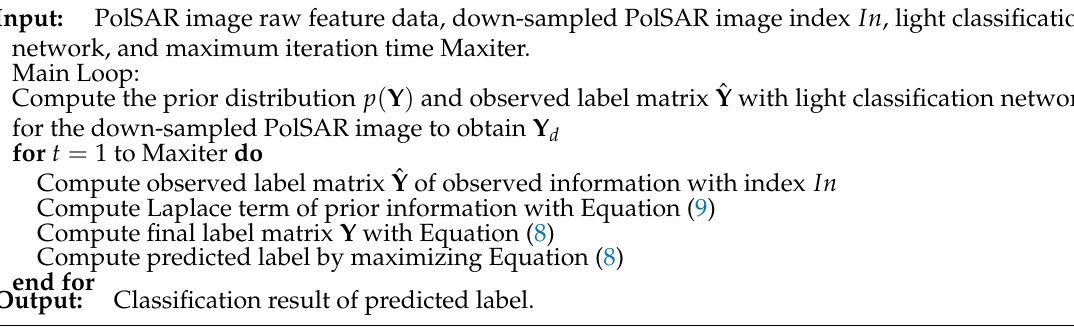
Algorithm 1 Optimization of proposed